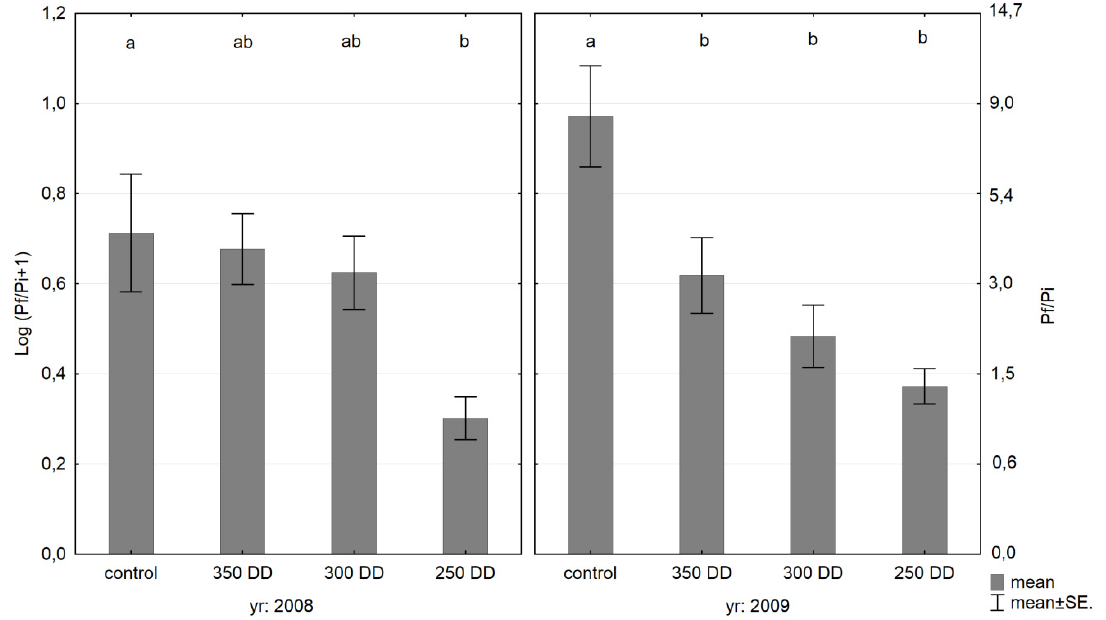
Figure 6. Multiplication rates Pf / Pi (log ( x + 1) transformed left axis; untransformed right axis) of beet cyst nematodes (BCN) under simulated volunteer oilseed rape without control (svOSR) and after glyphosate treatment at 250 DD (svOSR 250 DD), at 300 DD (svOSR 300 DD) and 350 DD (svOSR 350 DD) in micro-plots; means only within years were tested by Fischer LSD Test ( p < 0.05), different letters indicate significant differences.